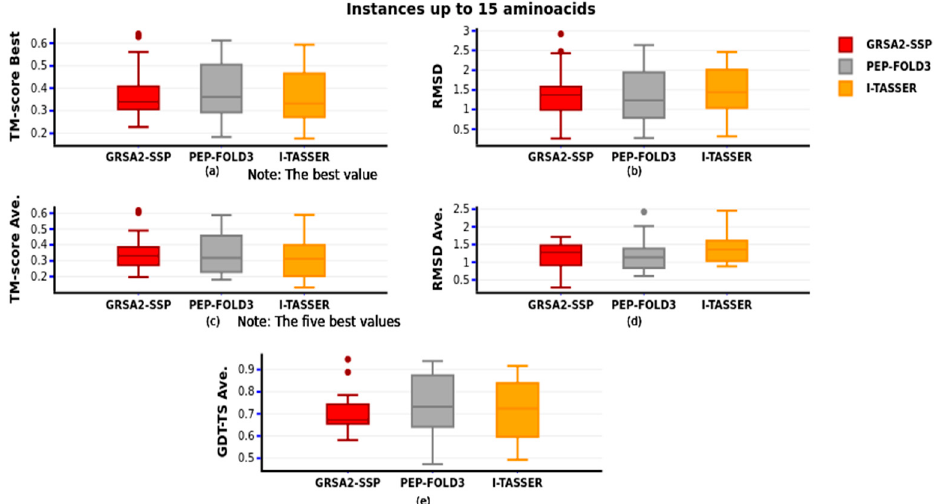
Figure 9. Comparison of GRSA2-SSP, PEP-FOLD3, and I-TASSER by RMSD (up to 15 amino acids). Figure 9 ( a ) best TM-score and ( b ) their RMSD, ( c ) TM-score average of the five best predictions, ( d ) RMSD average of the five best predictions, ( e ) GDT-TS average.